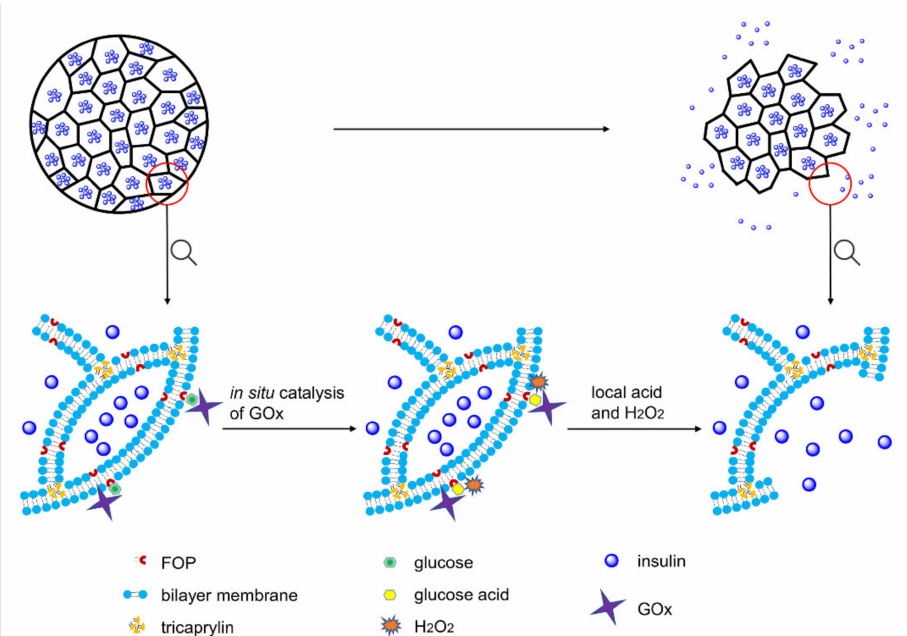
Figure 1. Insulin is released from the glucose-responsive multivesicular liposomes (MVLs) under high glucose conditions. FOP, (3-fluoro-4-((octyloxy)carbonyl)phenyl)boronic acid; GOx, glucose oxidase; H 2 O 2 , hydrogen